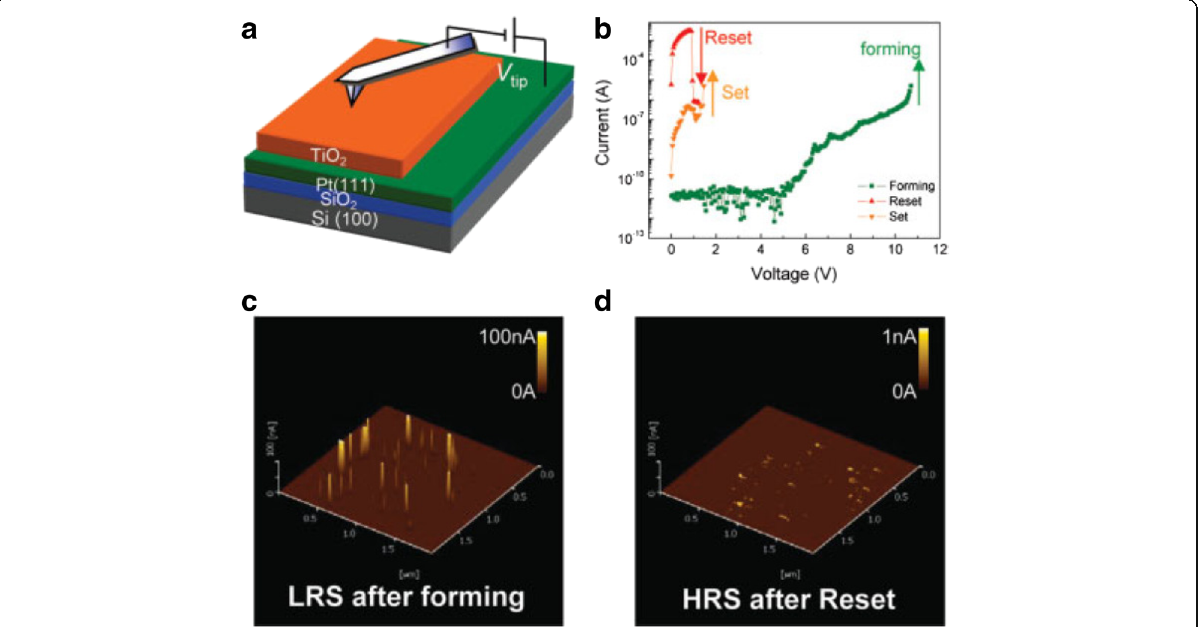
Fig. 17 Conducting AFM (C-AFM) topographs of TiO 2 films. a Schematic of C-AFM measurements ( b ) Typical I - V curves of TiO 2 films using C-AFM tip as a top electrode. c At V tip = 8 V, mapping of the current flow through the surface just after the forming operationshows locally distributed conducting regions. d TiO 2 surface in the HRS shows locally distributed conducting regions disappear after reset operation with V tip = 1 V